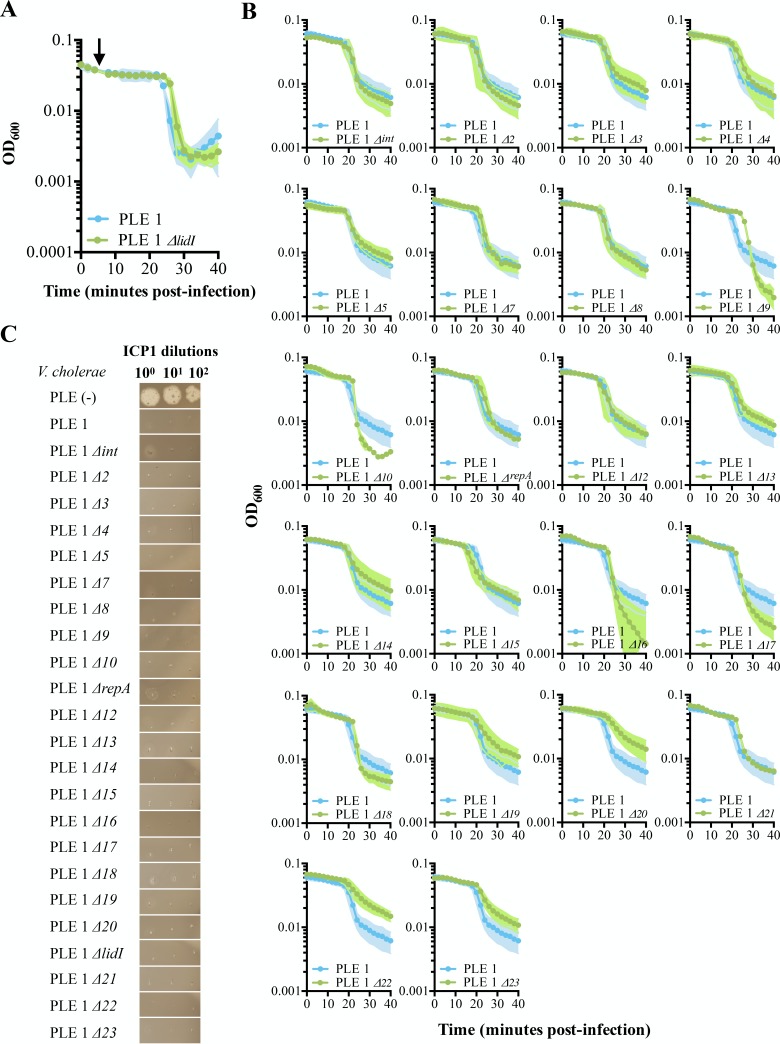
Redundancy in the PLE.(A) PLE one and PLE 1 ΔlidI were infected with ICP1 (MOI = 1) followed by superinfection (MOSI = 5; arrow) showing lysis inhibition is collapsed by PLE in the face of exogenously added phage. Every predicted PLE ORF was knocked out and each resulting strain was tested for accelerated lysis after ICP1 infection (MOI = 5) (B) and ability to inhibit plaque formation (C).